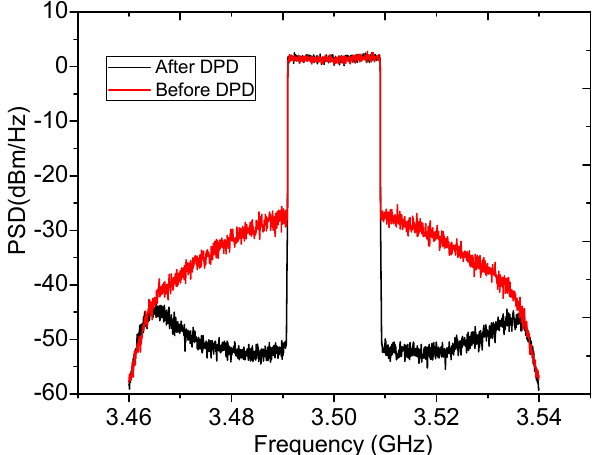
Figure 18. Measured adjacent channel ratio (ACLR) value.